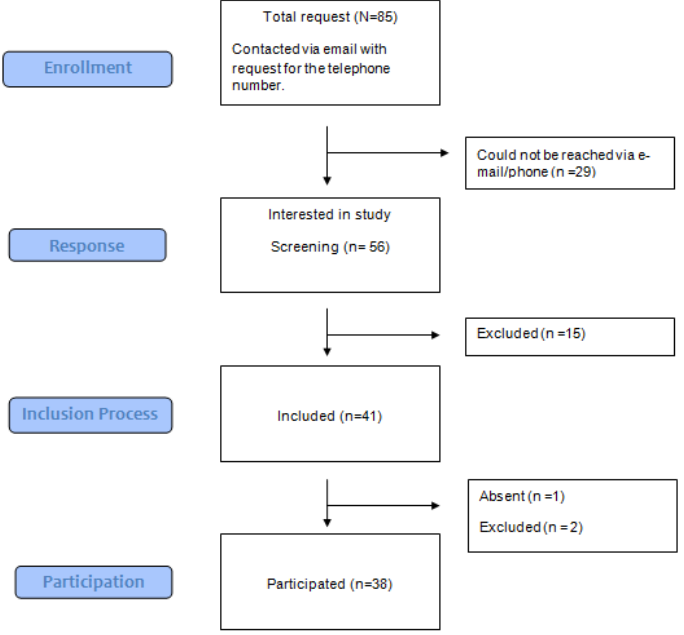
Figure 2. Recruitment of healthy controls.